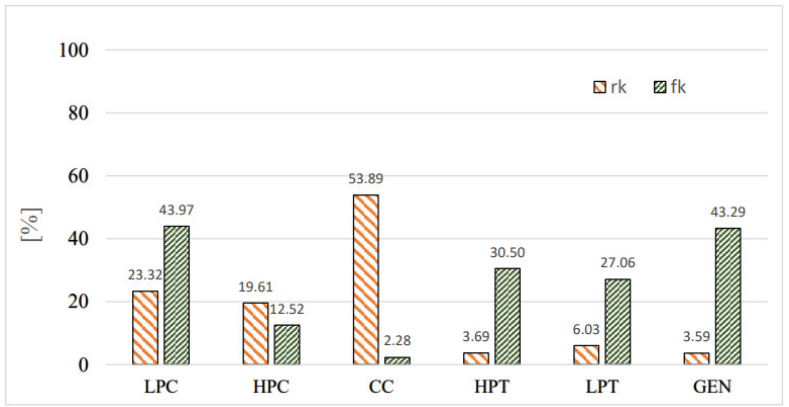
Figure 6. Exergoeconomic factor ( f k ) and relative difference in cost ( r k ) for the main components of the GT engine (Axial-centrifugal compressor).